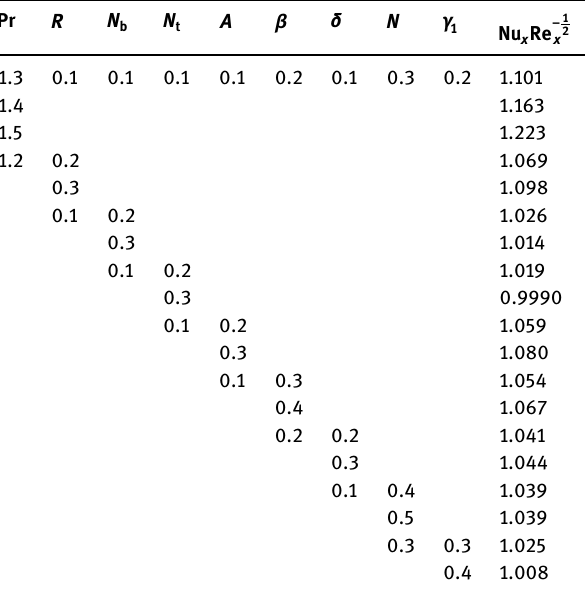
Table 4: Numerical values of the Nusselt number Nu Re x